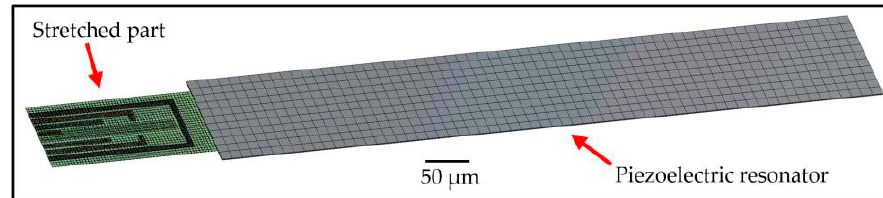
Figure 2. The meshed model of single clamped piezoelectric resonator linked mechanically to single clamped stretching device representing 2D material Hall Bar/FET